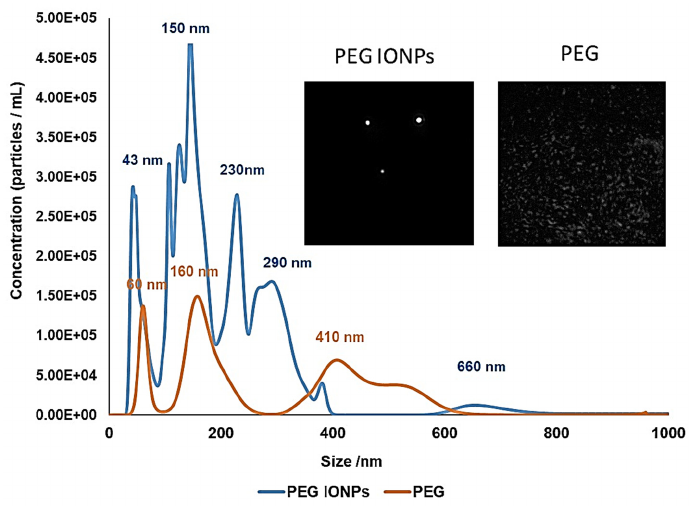
Figure 6. NTA measurements of concentrated PEG IONPs solution (blue) and concentrated PEG solution (orange), as control. Histograms are average of 3 measurements. Insets show screenshots of representative NTA video for both PEG IONPs and PEG only solutions.